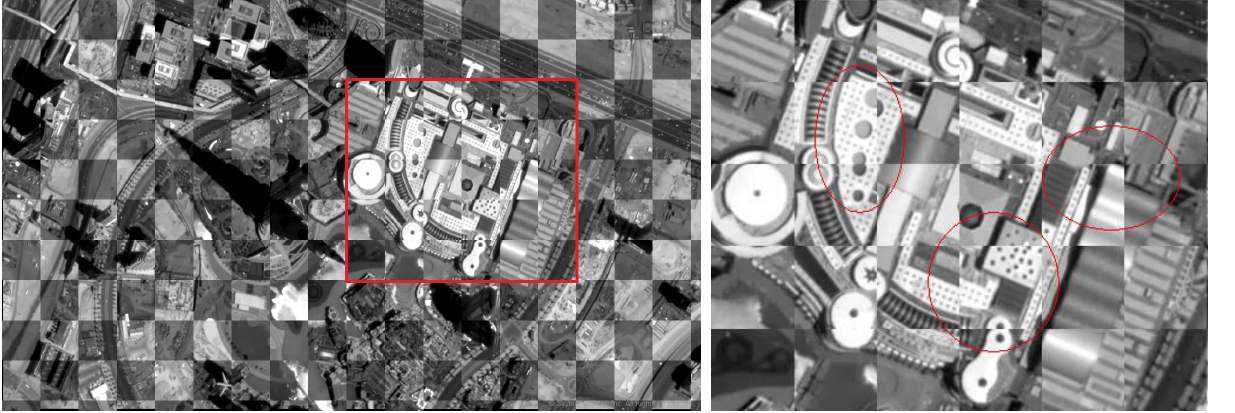
(c) Results from the descriptor-based registration in the Burj Khalifa video dataset (d) zoom-in area ( e.g., with certain errors inside the red circles)